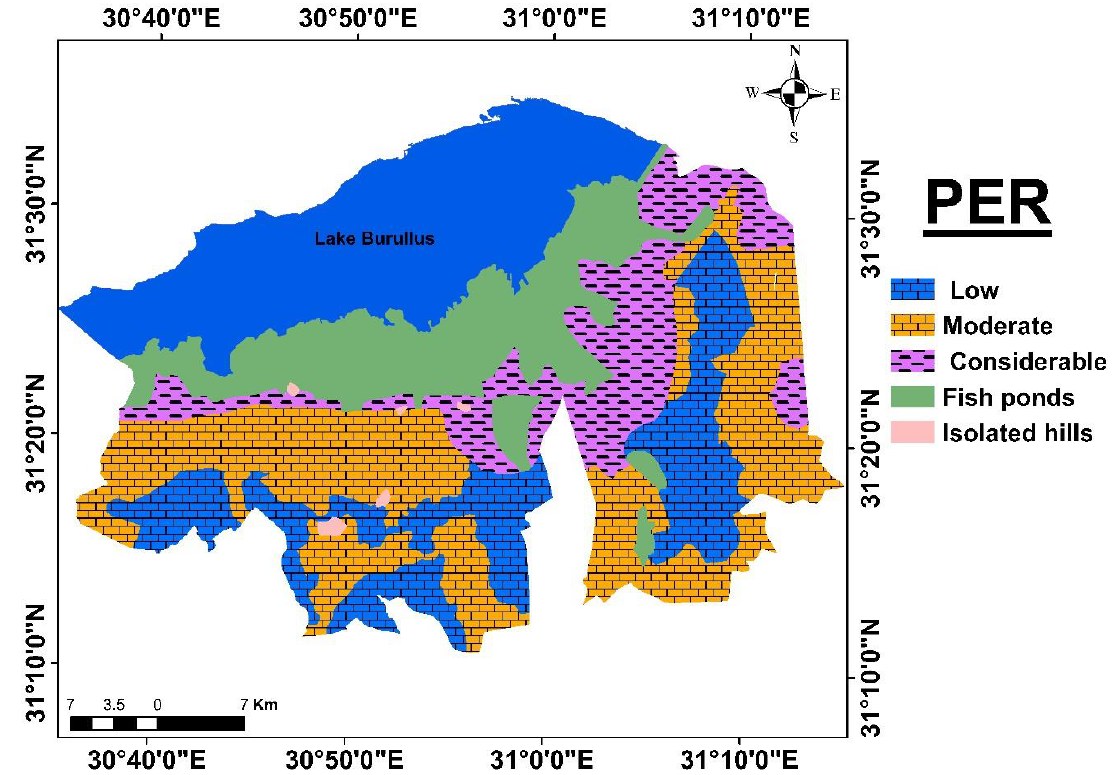
Figure 6. Potential ecological risk indices (PER) in the studied area.